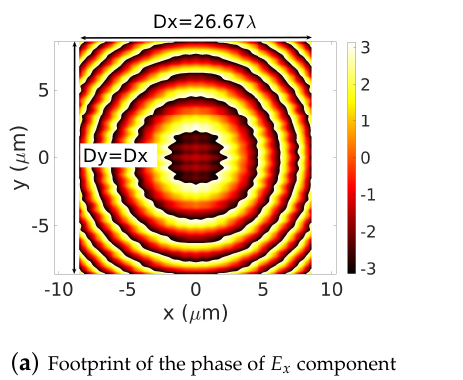
Figure 4. Sketch of a dipole field decomposition. The fundamental strategy of the DDSM to compute the footprint of a dipole field on an arbitrary large-area surface consists in dividing the surface into elementary sub-cells. Any component of the dipole field can then be locally simulated, on each sub-cell. Here, the surface z = − z s is subdivided into 3 × 3 sub-cells. ( a ) Dipole field decomposition and recomposition. ( b ) Sketch of simulation of metasurface under a dipole illumination.